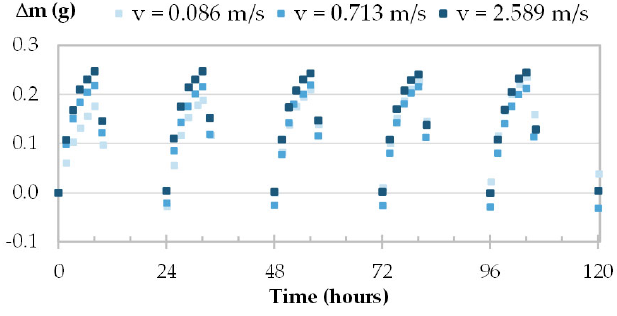
Figure 8. Moisture uptake and release kinetics for one specimen of GY (GY-c-3) in tests 1-2-3.